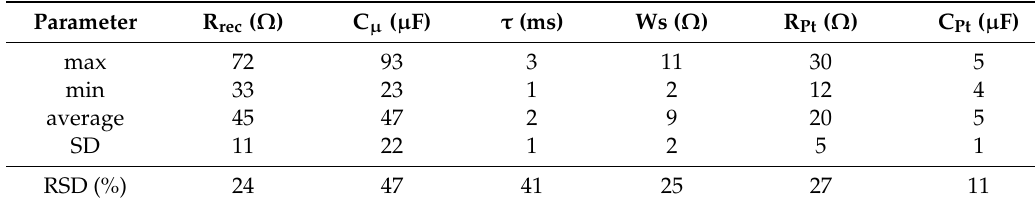
Table 6. Statistical data for the SQ2-based DSCs extracted from the fitted EIS parameters.